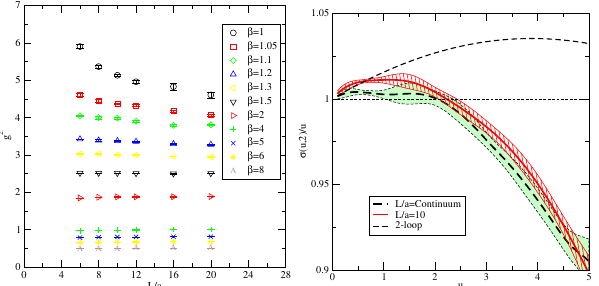
Figure 2. Left : The measured values of the Schrödinger functional coupling g 2 ( g 2 at different β L . Right : The scaled step scaling function σ ( u ,2 ) / u , u = g 2 , using only the largest volume pairs ( L / a = 10 and 20) (red hashed band) and with continuum extrapolation (green shaded band). The black dashed curve shows the universal 2-loop perturbative